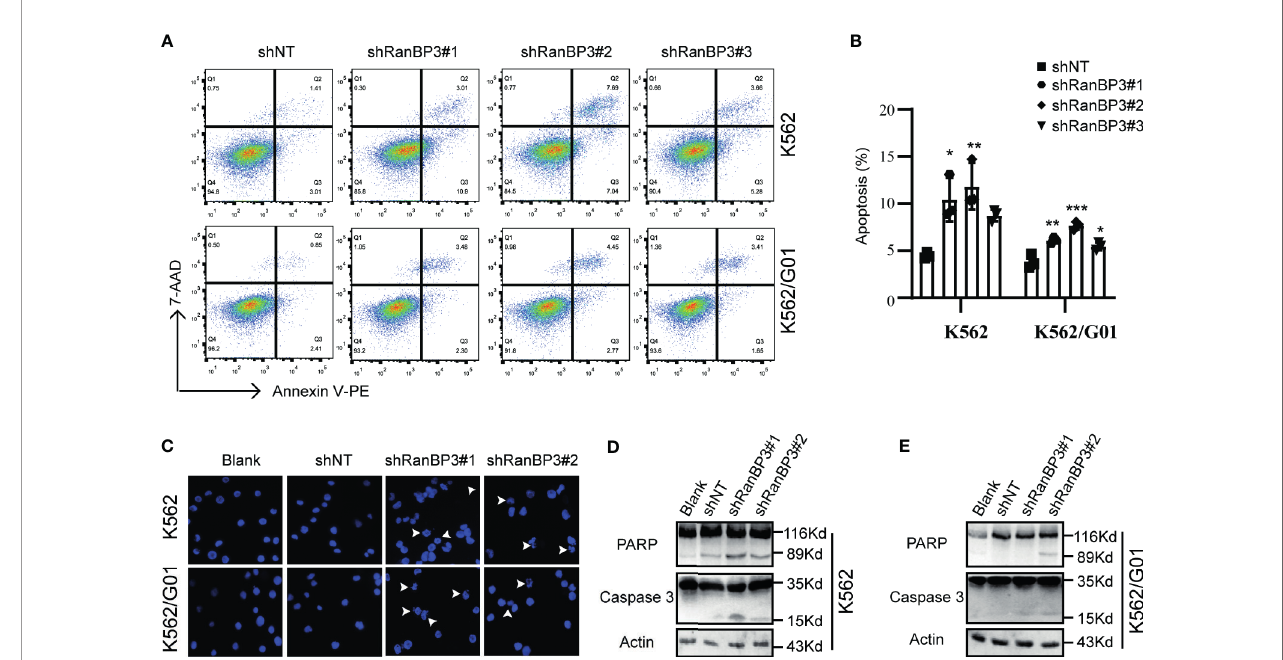
FIGURE 3 | Effect of RanBP3 on the apoptosis of CML cells. (A) Infected cells were labeled with Annexin V-PE and 7-AAD and examined by FCM. (B) The apoptosis results of three times in (A) were recorded and plotted as a bar graph. (C) DAPI staining was used to assess morphologic changes in apoptosis. The prominent apoptotic morphologies were indicated using white arrows. (D, E) Cleaved PARP and Caspase-3 were evaluated by western blot in lentivirus infected cells. *P < 0.05, **P < 0.01, ***P <